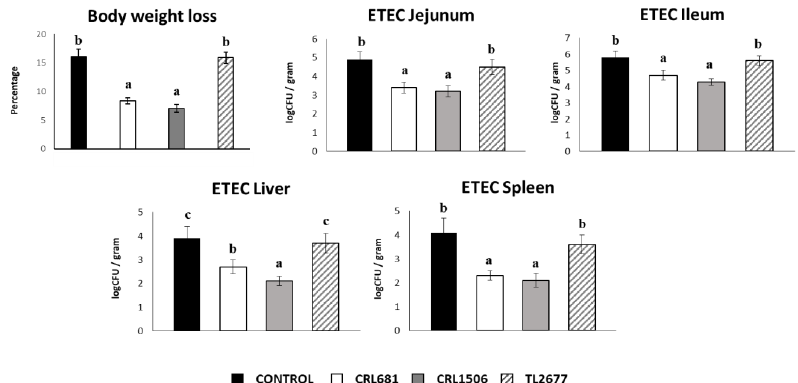
Figure 7. Immunomodulatory effect of Lactiplantibacillus plantarum CRL681, CRL1506 or TL2677 in